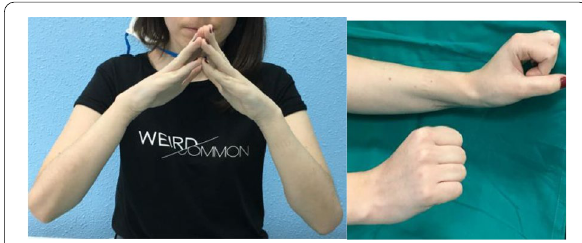
Fig. 2 Isolated joint contracture due to sclerosis: P‑ROM score of 1 in wrist joints (Buddha prayer posture). Joint stiffness improves with the fingers flexed, probably reflecting the fibrotic involvement of the flexor tendons of the